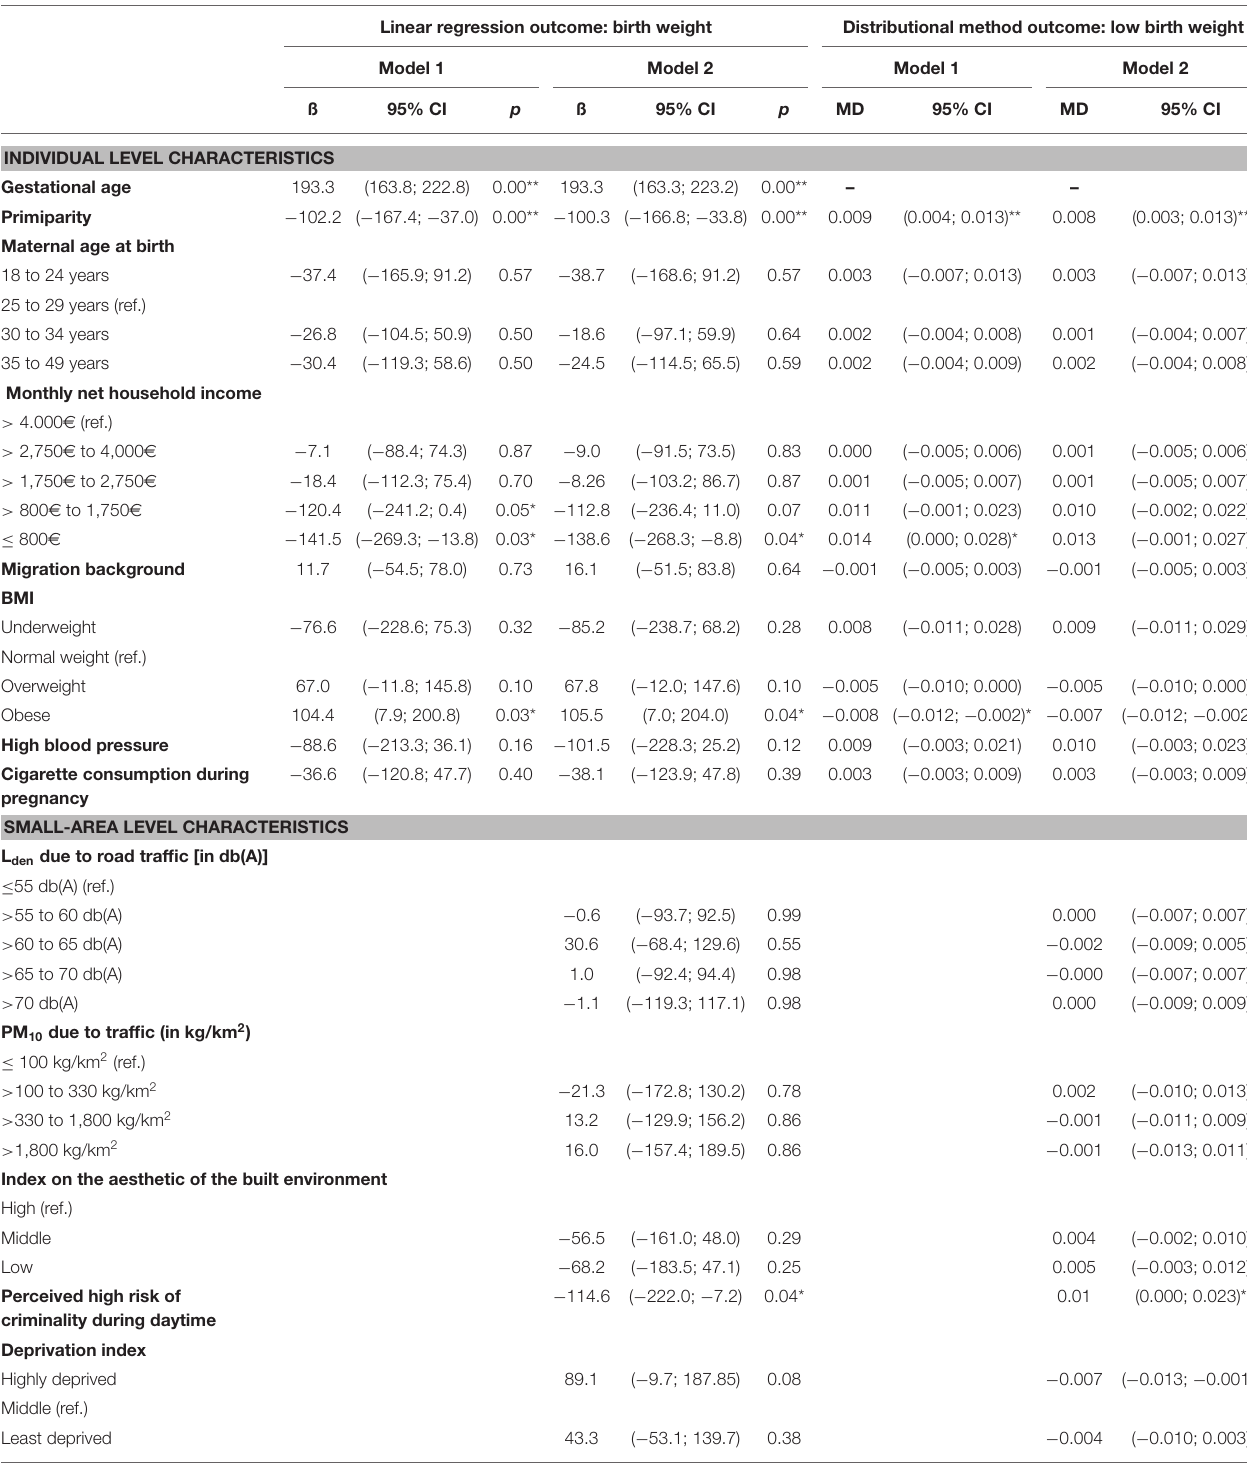
TABLE 2 | Multivariate analysis of (low) birth weight for individual and small-area level characteristics ( n =